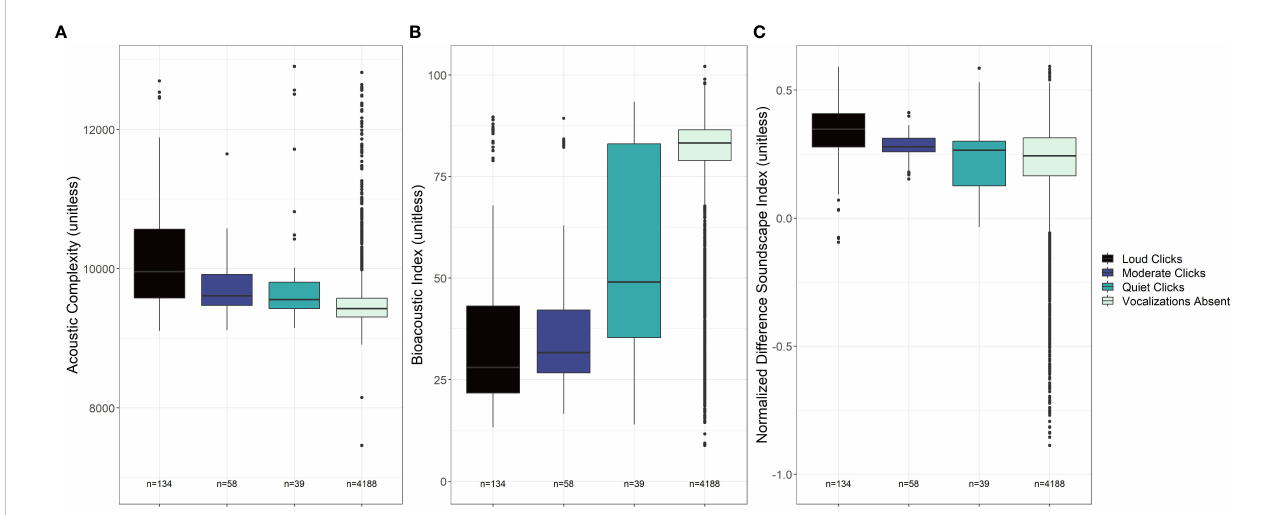
FIGURE 6 Box plots of measurements from three acoustic indices for sperm whale clicks parsed out by amplitude quality. Qualitative groups of clicks include ” Loud clicks, “ ” Moderate clicks, “ and ” Quiet clicks. “ Periods lacking any echolocation clicks (labeled ” Vocalizations Absent “ ) are also included for reference in all three fi gures. Sample sizes for each click quality level and period lacking vocalizations are indicated. The acoustic indices in this fi gure include the Acoustic Complexity Index, the Bioacoustic Index, and the Normalized Difference Soundscape Index.